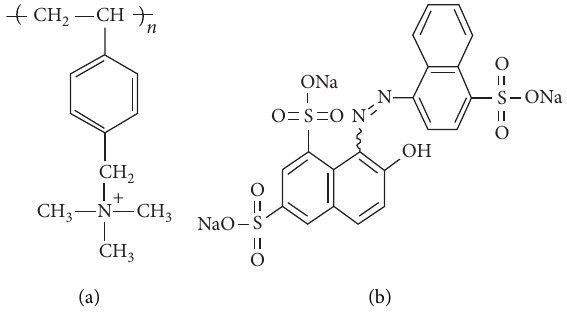
Figure 1: Chemical structures of (a) PVBTAC and (b)